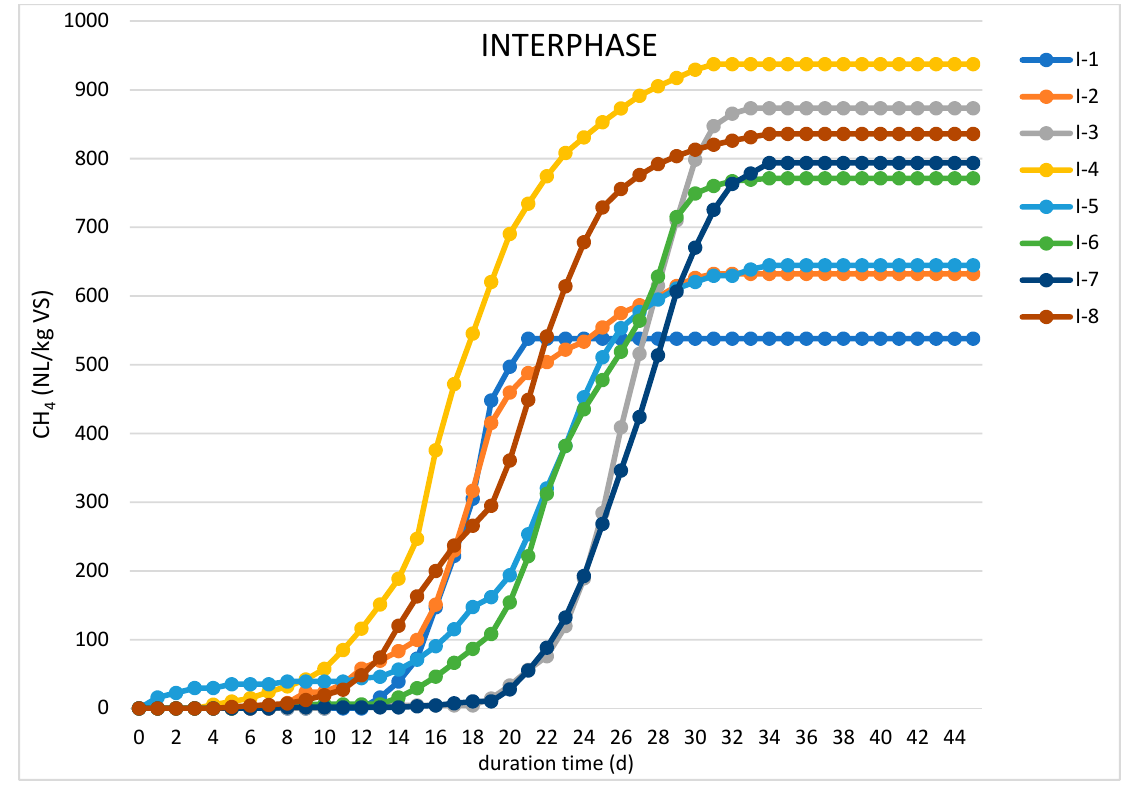
Figure 2. Average cumulative methane production from interphase in batch digestion experiments.